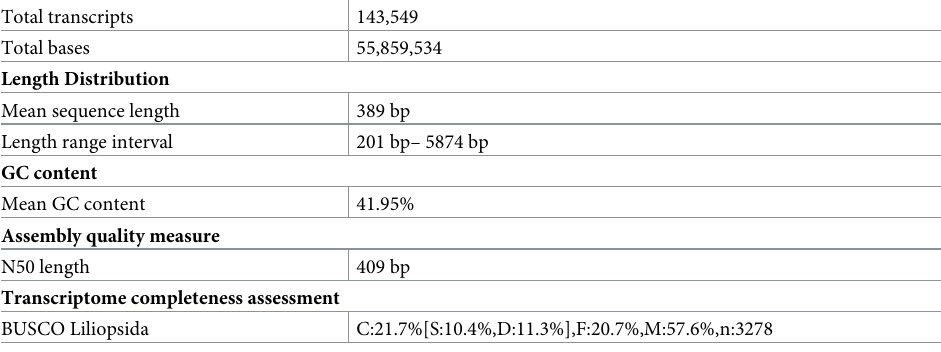
Table 1. Statistical summary of the Trinity de novo transcriptome assembly of Hypoxis hemerocallidea